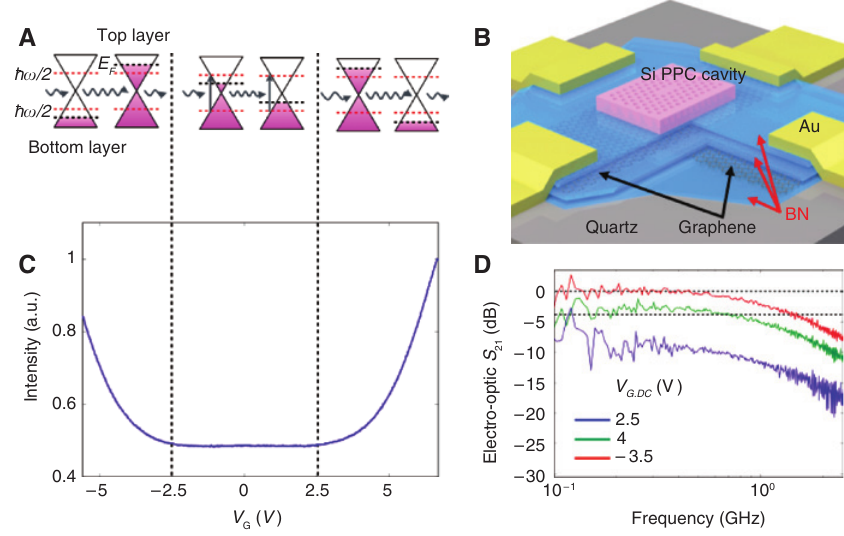
Figure 2: (A) Schematic of the electro-absorptive effects in a capacitor structure consisting of two graphene layers (“top” and “bottom”) separated by hBN. When the Fermi level in graphene rises (drops), the absorption of graphene reduces due to the Pauli blocking of the interband transition of the electrons in graphene. (B) Schematic of the high-speed graphene E-O modulator [10]. (C) Normalized reflection intensity as a function of the gate voltage ( V ). (D) Normalized E-O S21 of the graphene E-O modulator as a function of G